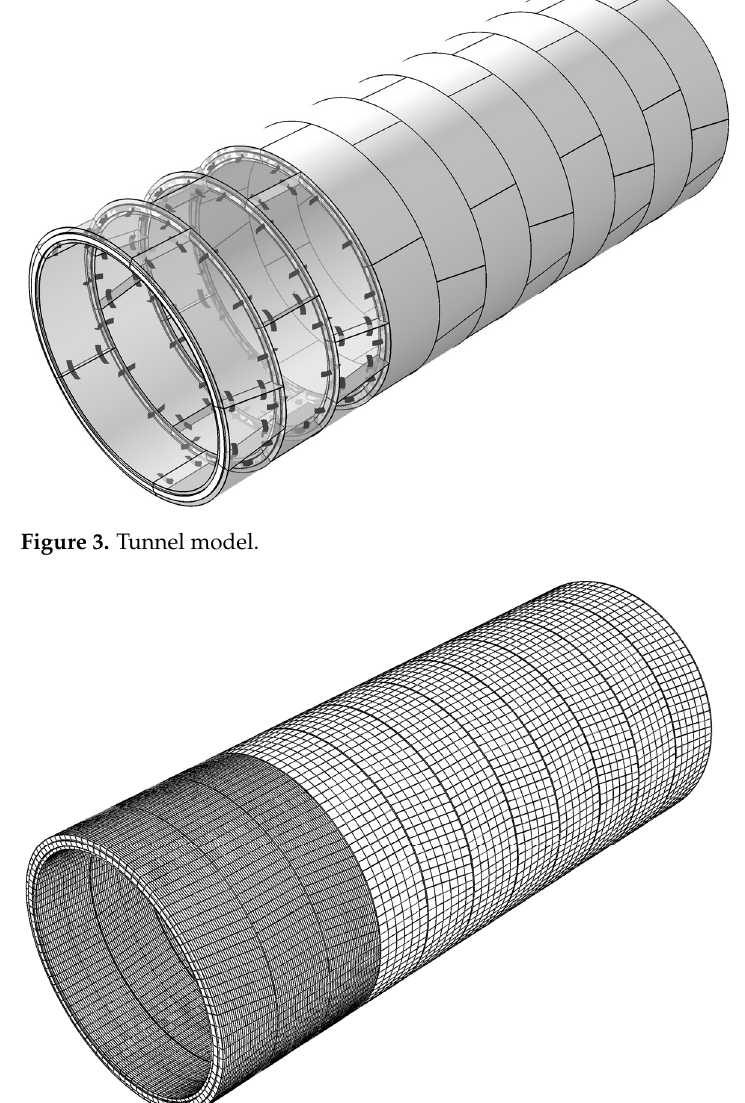
Figure 4. Mesh of numerical model.